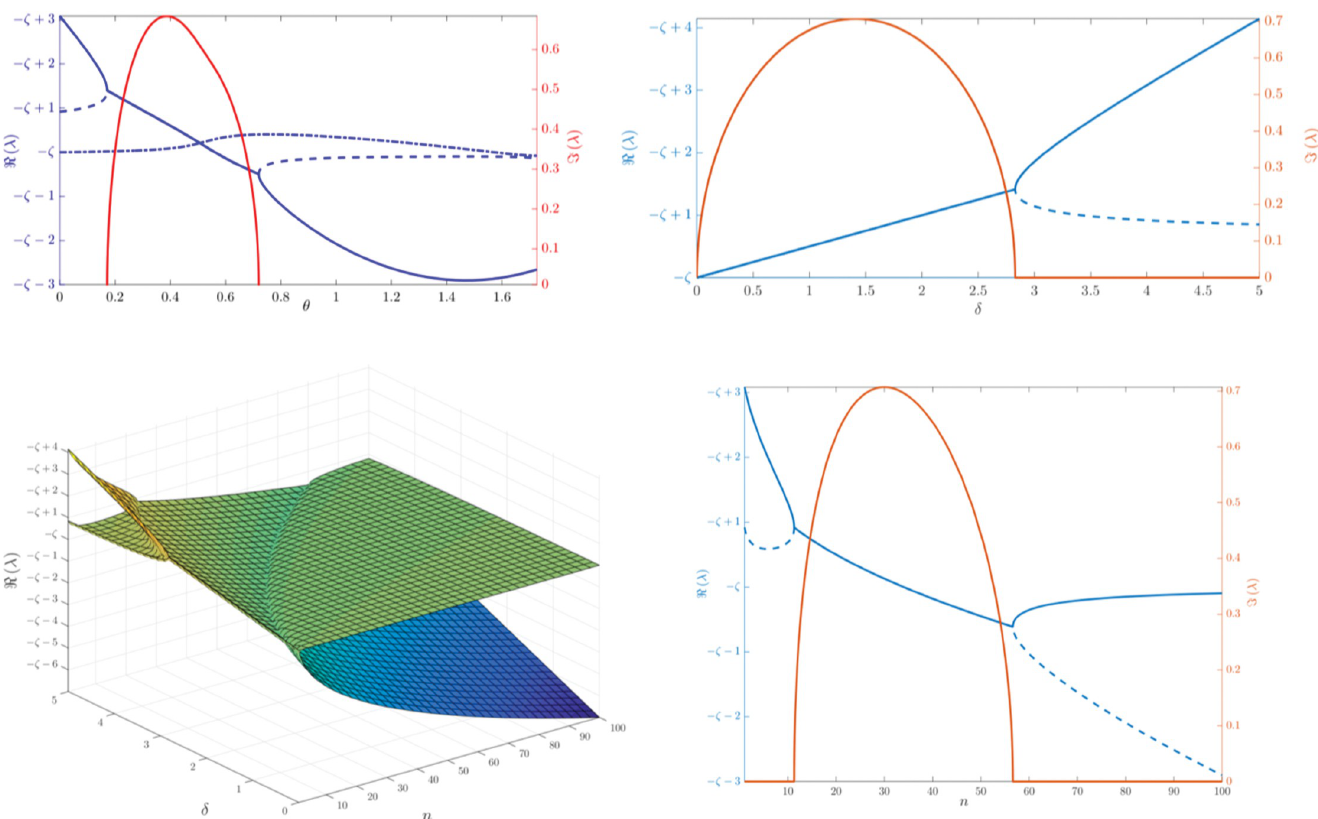
Fig 5. The Lyapunov exponents. Top left: The real and imaginary parts (up to sign) of the three significant Lyapunov exponents, plotted as a function of θ , with parameters n = 100, β = 1 and δ = 4. Note there is a range of θ values where two of the Lyapunov exponents form a complex conjugate pair (here we only depict the one with positive imaginary part). The positivity of the Lyapunov exponents depends on the value of z . Since 0 < z < z + γ = δ (= 4 in this case), the answer generally depends on the relation between γ and z , i.e. the cell reproduction rate and virus decay rate, respectively. Top right: The real and imaginary parts (up to sign) of the two significant Lyapunov exponents λ as a function of δ , plotted for β = 1 and θ = 0; i.e., the maximally-entangled case. In this case the Lyapunov exponents no longer ffiffiffi p depend on n . Note the sharp transition occuring at d ¼ 2 2 b : for δ � δ c , < ( λ ) = ( γ − z )/2, and the two Lyapunov exponents comprise a complex conjugate pair; thus, c we may expect unstable behavior iff γ > z . However, for δ > δ this is no longer true, as the upper branch exceeds the continuation of the line < ( λ ) = δ /2 − z . Bottom c left: the real parts of the two significant Lyapunov exponents λ as a function of n and δ , plotted for θ = θ max and β = 1 (the equally-correlated case). The plot to the bottom right depicts the ( δ = 4)-cut of the left plot, and illustrates both the real and imaginary parts (up to sign) of the Lyapunov exponents. The Lyapunov exponents ffiffiffi p form a complex conjugate pair for δ − < δ < δ + , where d ¼ b ð n þ 1 Þ ffiffiffi 2 b , and the imaginary part obtains its maximal absolute value for d ¼ b ð n þ 1 Þ ffiffiffi p � p . Note that for small � 2 n 2 n values of n , the plot resembles the maximally-entangled case. This is not surprising, since for n = 1 the two cases converge. Large n behavior can be observed as well: ffiffiffiffiffiffiffiffi p note how the larger Lyapunov exponent approaches − z , while the smaller one approaches g (cid:0) b n = 2